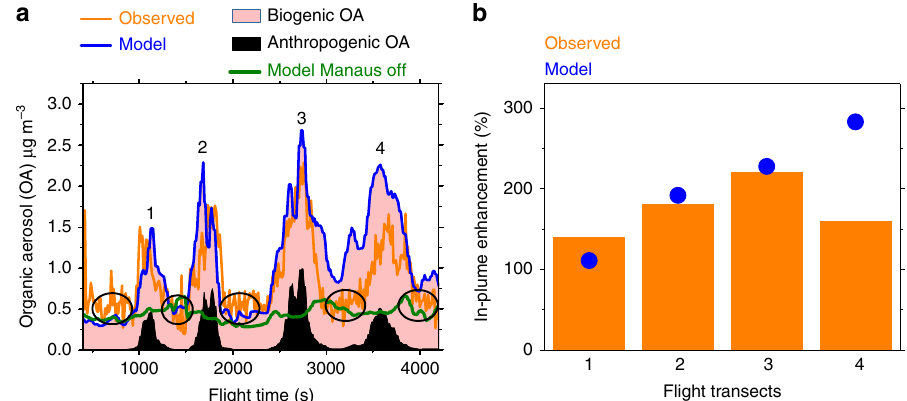
Fig. 1 Aircraft measurements and model predictions demonstrating large OA enhancements within the urban plume compared to the pristine Amazonian background. a Total organic aerosols (OA) measured along aircraft fl ight transects at 500-m altitude on March 13 (orange) and model-predicted OA for simulations with all emissions on (blue), and biogenic emissions on but Manaus emissions off (green, representing background OA), as described in the text. The shaded regions depict simulated biogenic and anthropogenic OA components. b Measured and model predicted average percent enhancement in plume compared to background organic aerosol on 4 different fl ight transects, as marked in a . The fi gure shows four different transects when the aircraft intersected the Manaus plume marked as 1 – 4, while background (outside plume) concentrations are ~0.5 μ g m − 3 , indicated by the open circles. Bars represent measurements while symbols represent model-predicted increases of OA within Manaus plume compared to background